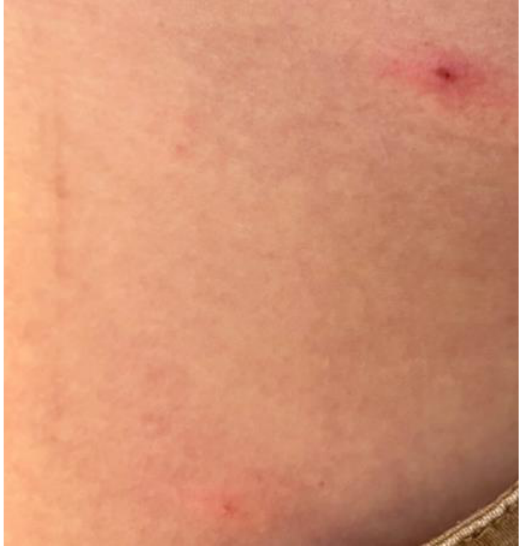
Figure 2. Clinical features related to some pustules on the trunk of the patient 1.